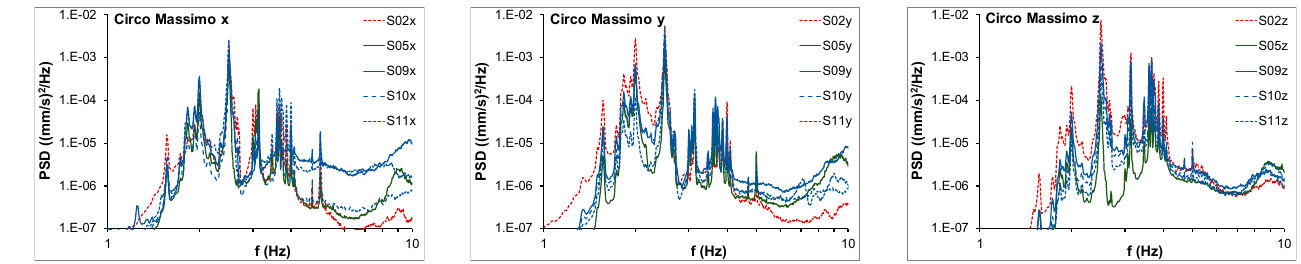
Figure 7. PSDs of the recordings on the ground for the entire time length. In Figure 8, the energy and the first resonance frequency at S02, S05, and S09 are plotted. Energy was estimated for each consecutive 5-min time interval as the area below the PSD for that interval; the dominant frequency for each interval was then estimated as the frequency of the peak PSD. The variation of both of them was significant during the recordings. The influence of the concert can be seen.